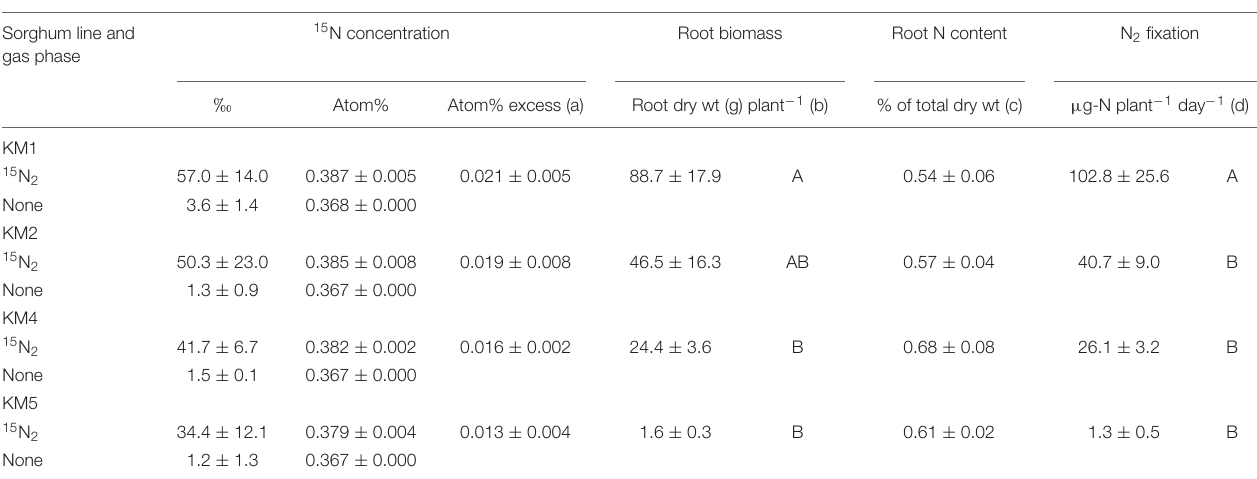
TABLE 2 | Incorporation of 15 N from 15 N 2 into sorghum roots at 102 days after transplant a . 15 N concentration Root biomass Root N content Sorghum line and gas phase